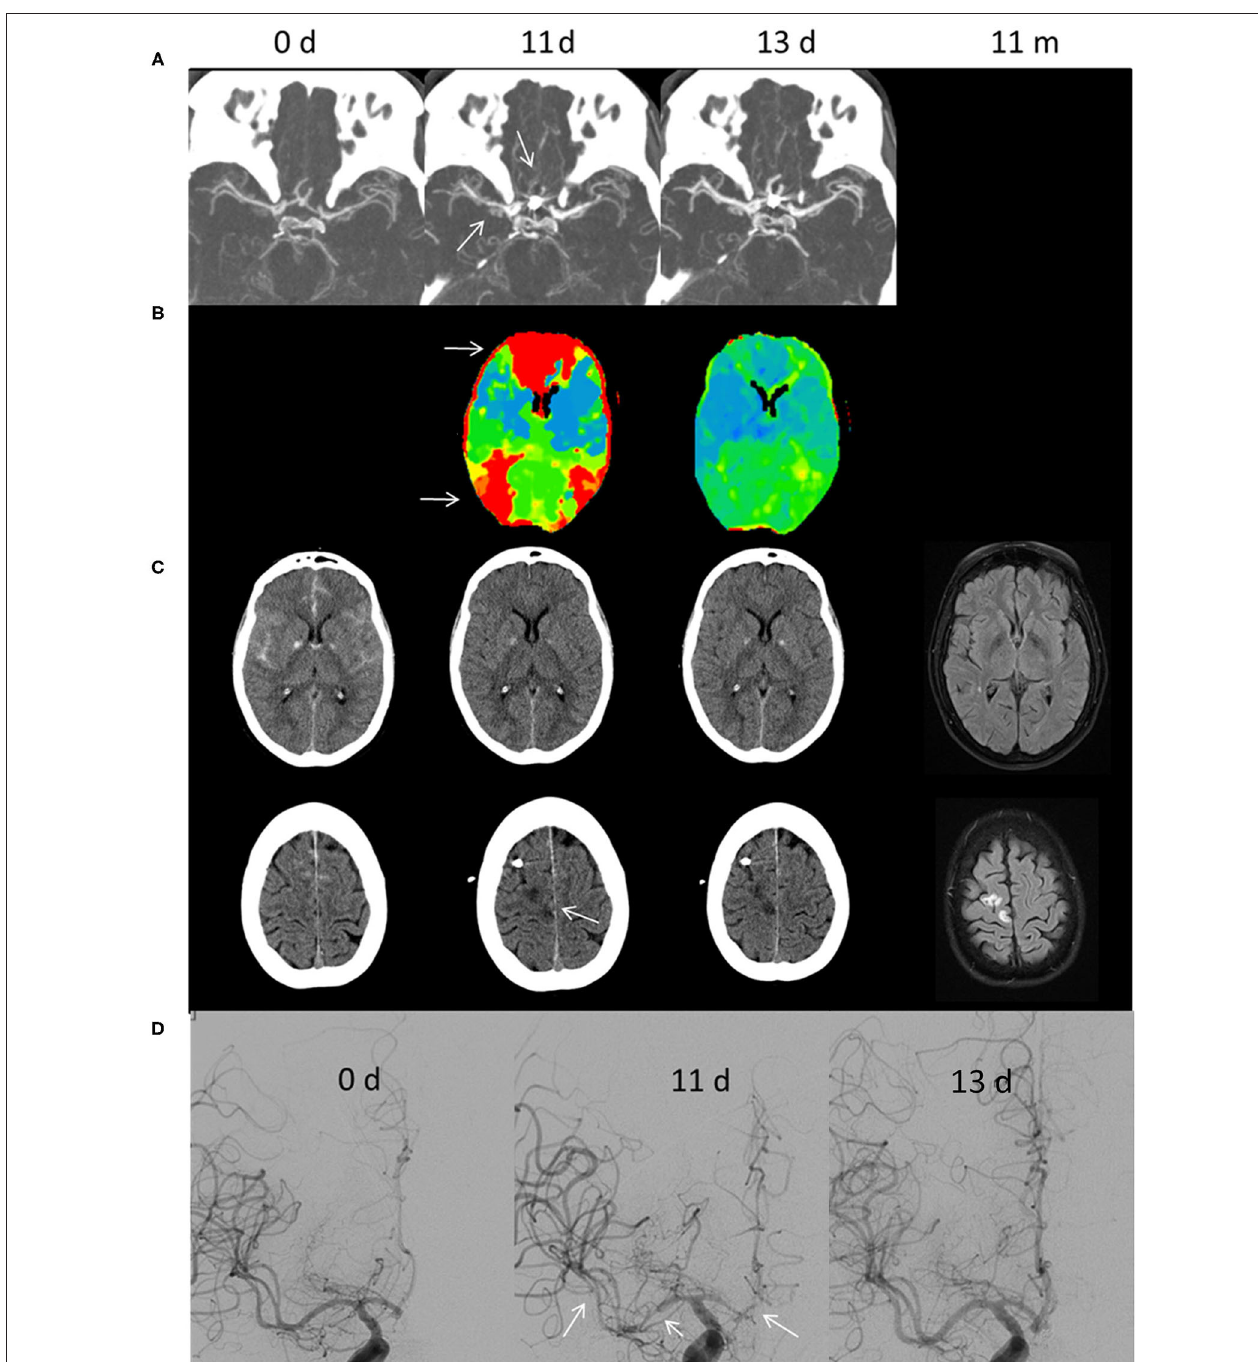
FIGURE 1 | Illustrative case of CIAN therapy. (A) CT angiography, (B) perfusion CT, (C) cranial CT and T2-weighted fluid-attenuated inversion recovery, and (D) digital subtraction angiography. The time is given in days (d) and months (m) after aSAH. The initial cranial CT shows aSAH Fisher Grade III due to rupture of an AcomA-aneurysm, which was subsequently treated by coil embolization. On day 11, the MTT (CBV normal, not shown) was prolonged predominantly in the ACA and distal MCA/watershed territories (white arrows in B ). In addition, a small sub-/cortical infarction within the right ACA territory was diagnosed (arrow in C ). DSA showed severe large vessel vasospasm of the right MCA and ACA segments (arrows). CIAN was commenced immediately. Two days later (day 13) MTT in the ACA territory normalized and no new infarctions could be diagnosed in CT. Likewise, vessel diameter normalized as shown in DSA. In a follow-up MRI 11 months later no new infarctions were